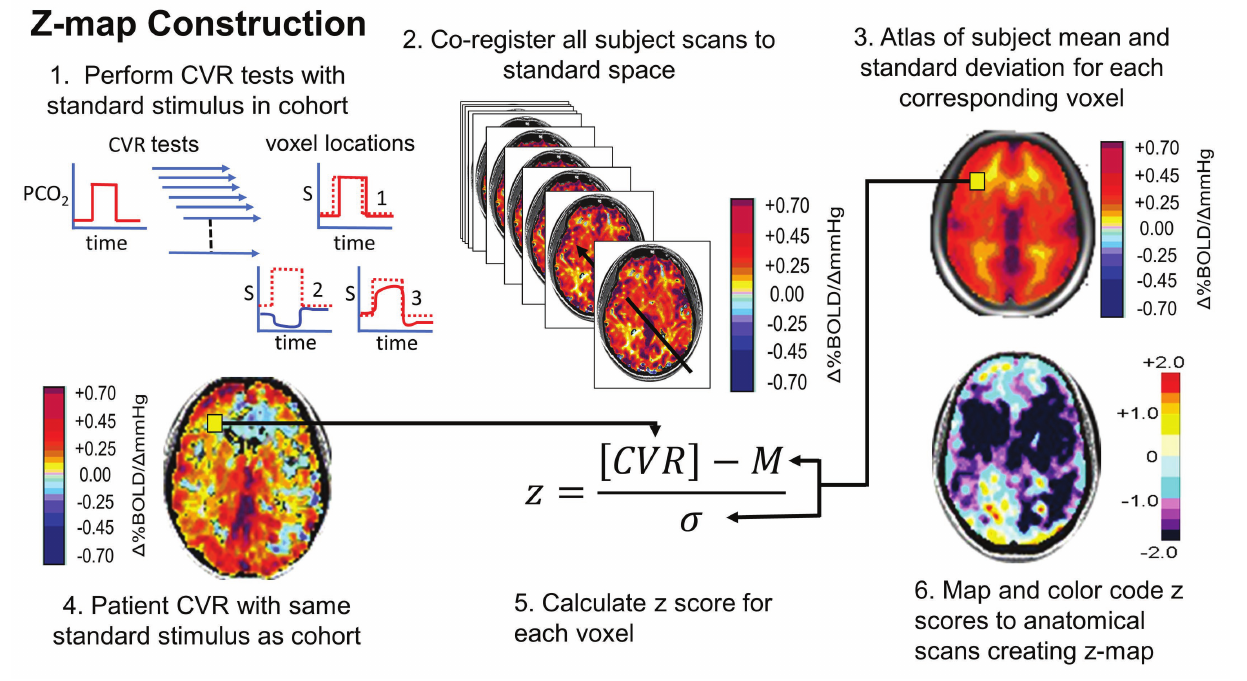
FIGURE 7 | Normalizing the CVR score in terms of the normal range. An identical, repeatable stimulus is applied to a healthy cohort. CVR is calculated and mapped to standard space. Mean (M) and SD are calculated for each voxel. A patient is administered the same test. The patient CVR is assessed as z -scores. Z -scores can be color coded and mapped over the anatomical scan to show the distribution of abnormality (reprinted from Fisher et al., 2018 with permission of the